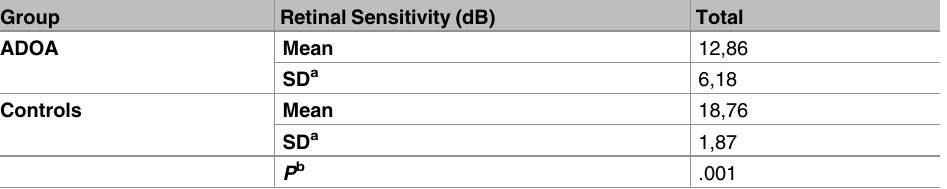
Previous studies carried out with TD-OCT have shown a significant reduction in average RNFL thickness in patients affected by ADOA [2,20,21,27,34,35]. These data have been con- firmed in other studies, reporting significant thinning of the pRNFL in the infero-temporal quadrant using the Fast RNFL scan protocol of TD-OCT [2,36]. Ito et al. described thinning of the macular inner retina using TD-OCT manual segmenta- tion, with preservation of the photoreceptor layer [35]. More recently, thickness of selected retinal layers has been measured using computer- assis- ted manual grading software analysis of the Spectralis SD-OCT macular scans [25]. RNFL and GCL thicknesses were significantly lower in ADOA patients than in controls, while there was Table 5. Mean PP differential sensitivity values measuredby MP1 comparing Autosomal-Dominant Optic Atrophy (ADOA) and Control Subjects. Group Retinal Sensitivity (dB) Total ADOA Mean Controls Mean P b